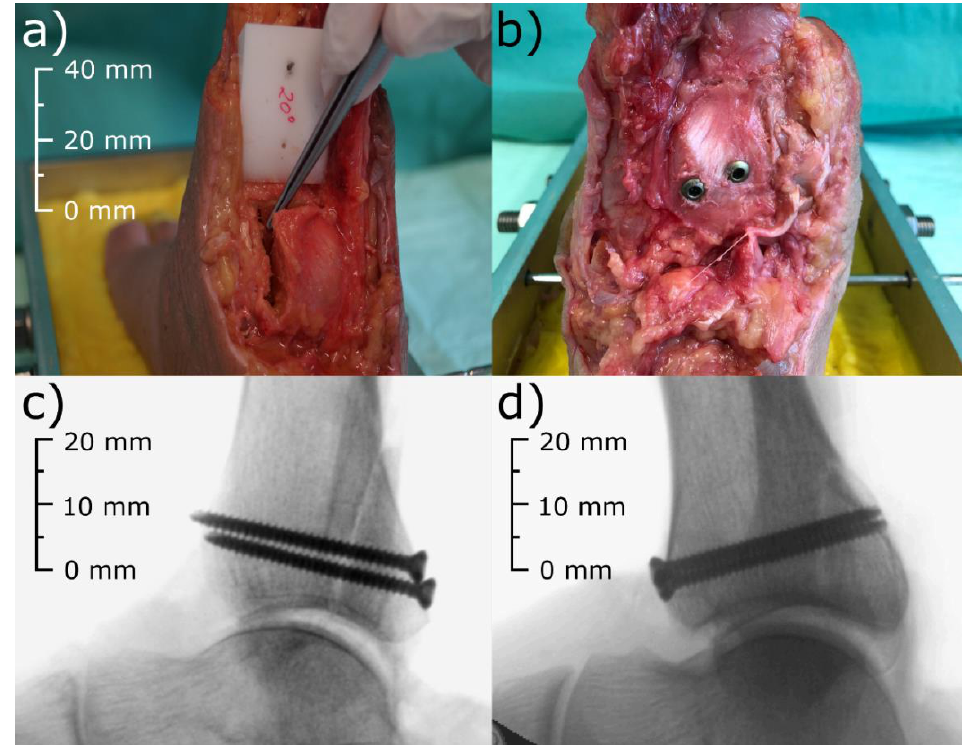
Figure 1. The figure shows in ( a ) the osteotomy of a fracture of the PM (type IV according to Bartoníček and Rammelt), in ( b ) the osteosynthesis by example using screws implanted from the posterior, in ( c ) the lateral X-ray image of the p.a. screw osteosynthesis and in ( d ) the a.p. screw osteosynthesis in the lateral X-ray.